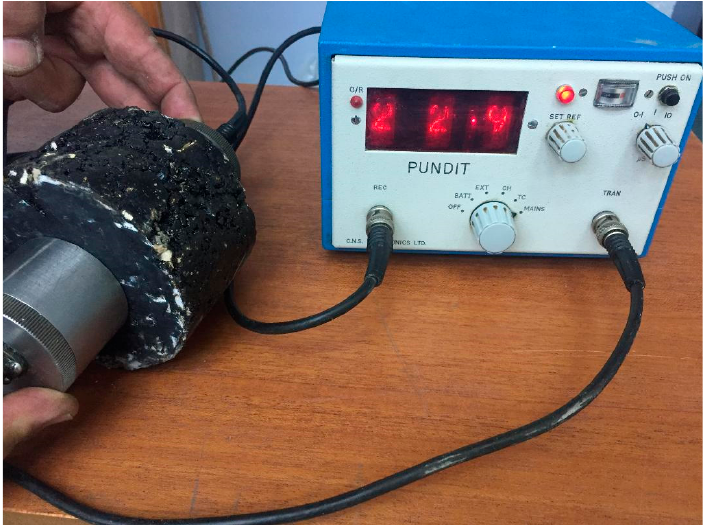
Figure 4. Ultrasonic pulse velocity measurement.